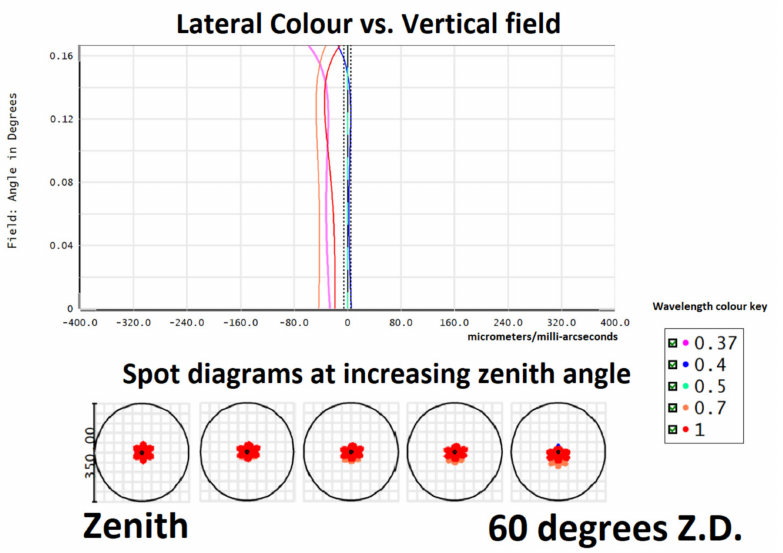
Figure 8. ( Top ) Lateral colour vs. field plot for the RoL-ADC at maximum (60 degrees) zenith distance. The residual secondary spectrum is of the order of 40 milli arcseconds. ( Bottom ) The spot diagrams show the secondary spectrum is almost eliminated over the whole range of zenith